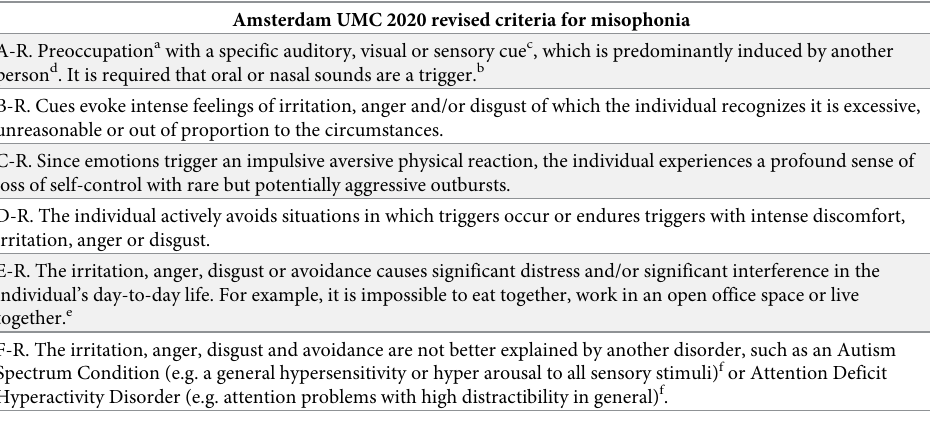
Table 5. Amsterdam UMC 2020 revised diagnostic criteria for